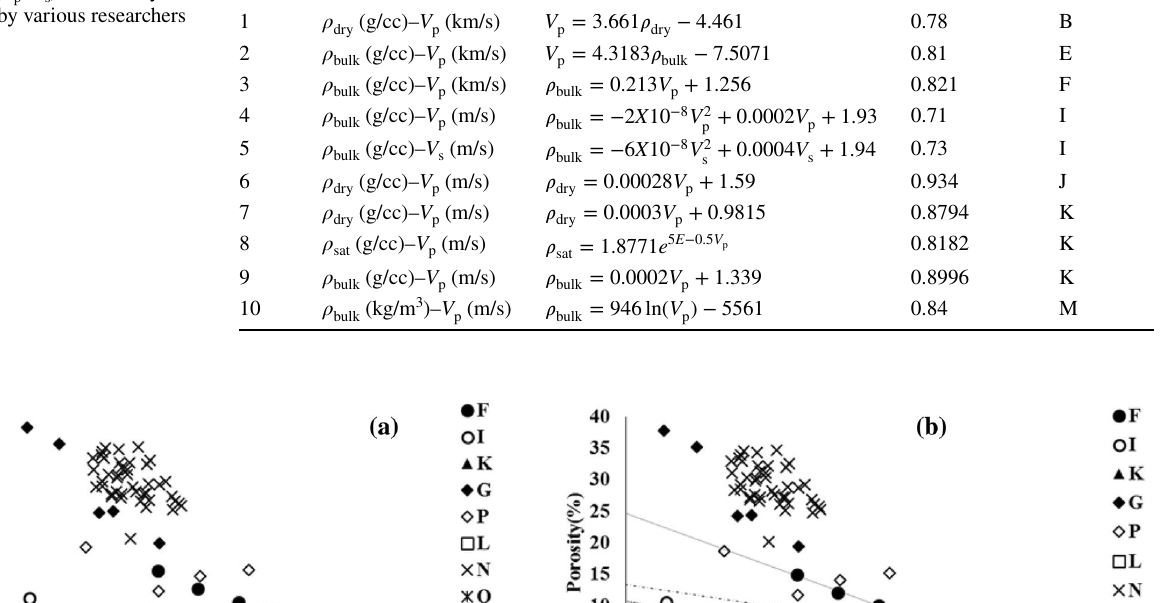
empirical equations derived for velocity ( V p , V s ) and density as reported by various researchers